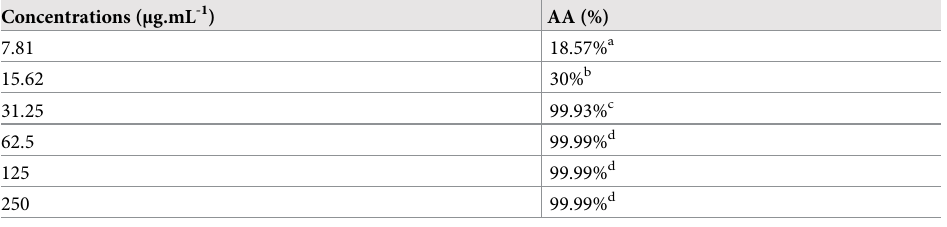
Table 5. Shows the percentage of antioxidant activity of ascorbic acid (vitamin C) in different concentrations. Concentrations ( μ g.mL -1 )